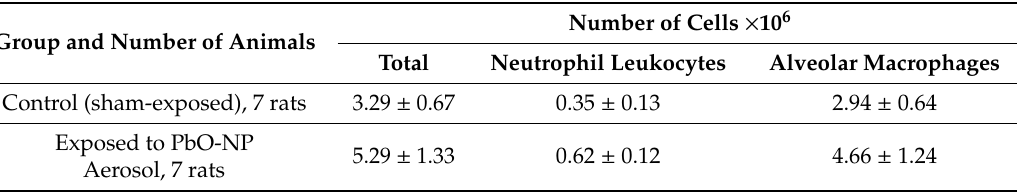
Table 1. Cell counts in the bronchoalveolar lavage fluid (BALF) in rats after repeated inhalation of